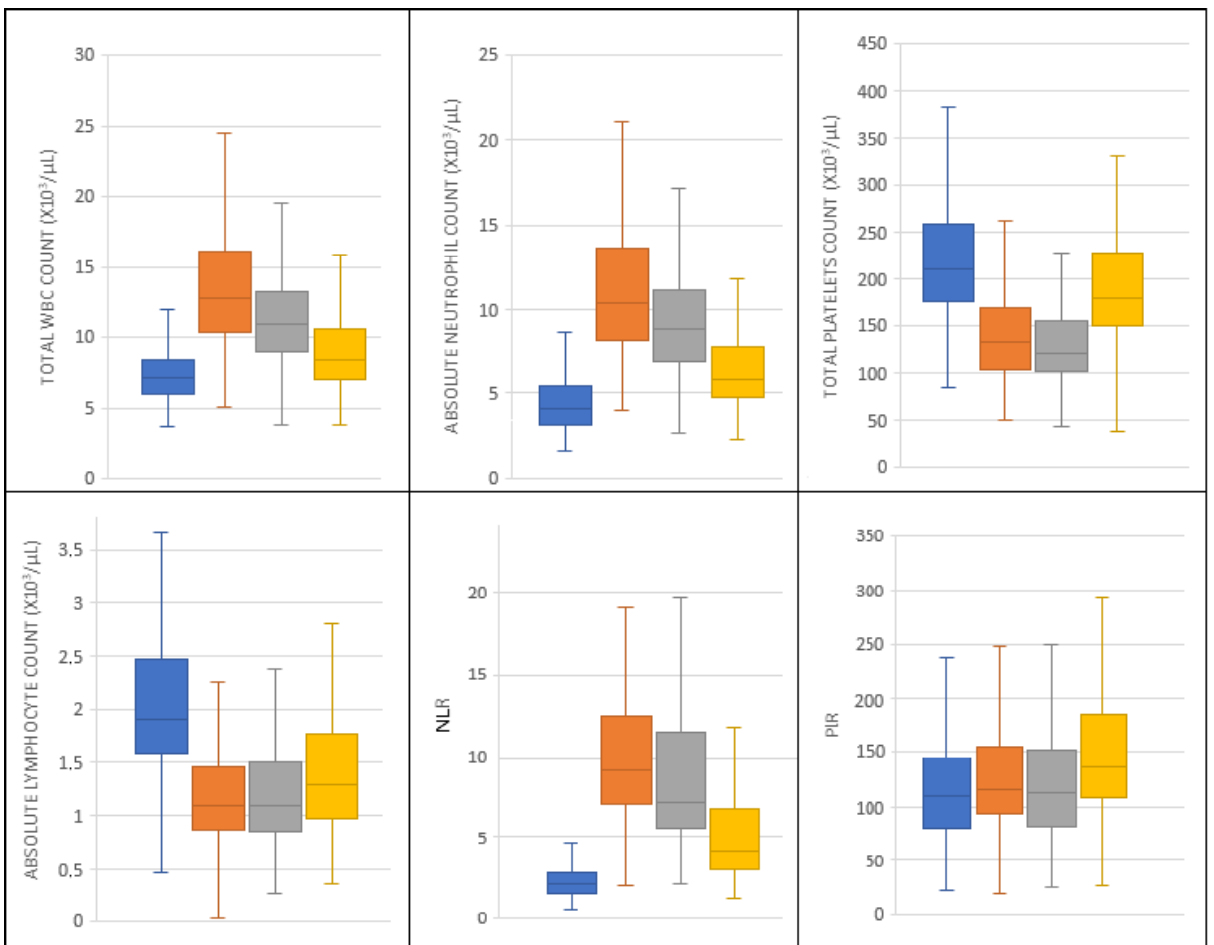
Figure 1. The fluctuations of hematological parameters and their derived indices preoperatively (blue) and on postoperative day 3 (orange), 5 (grey), and 7 (yellow). There is no sign of difference, or, in other words, no predictive value of NLR0 and PLR0 for patients who finally died ( p = 0.185 and p = 0.915, respectively). The mean